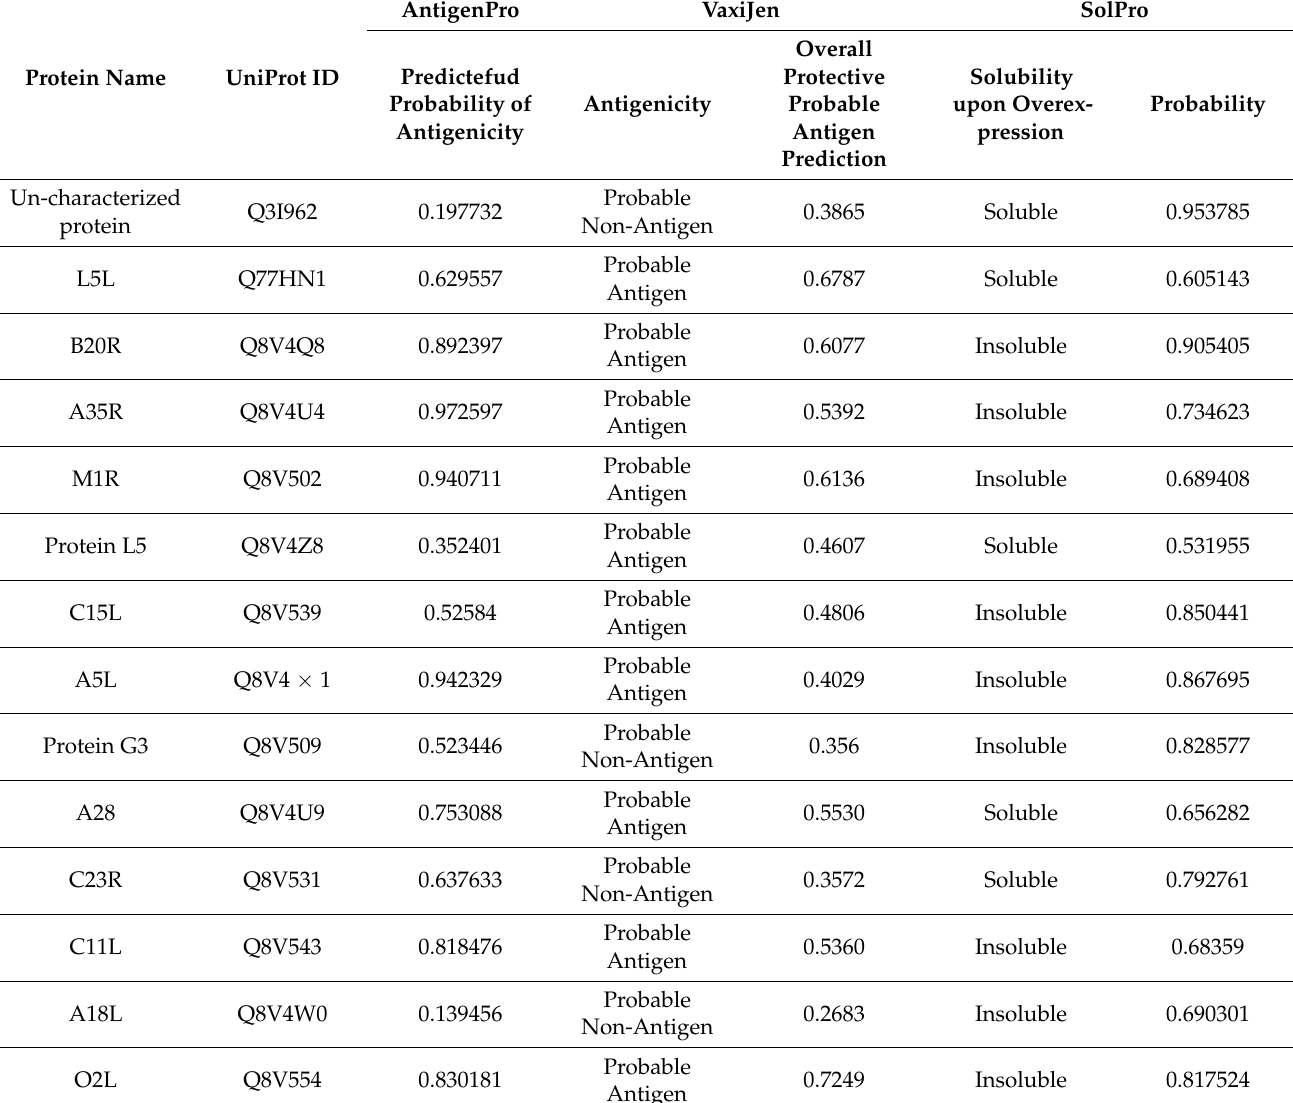
Table 1. Antigenicity and solubility of 14